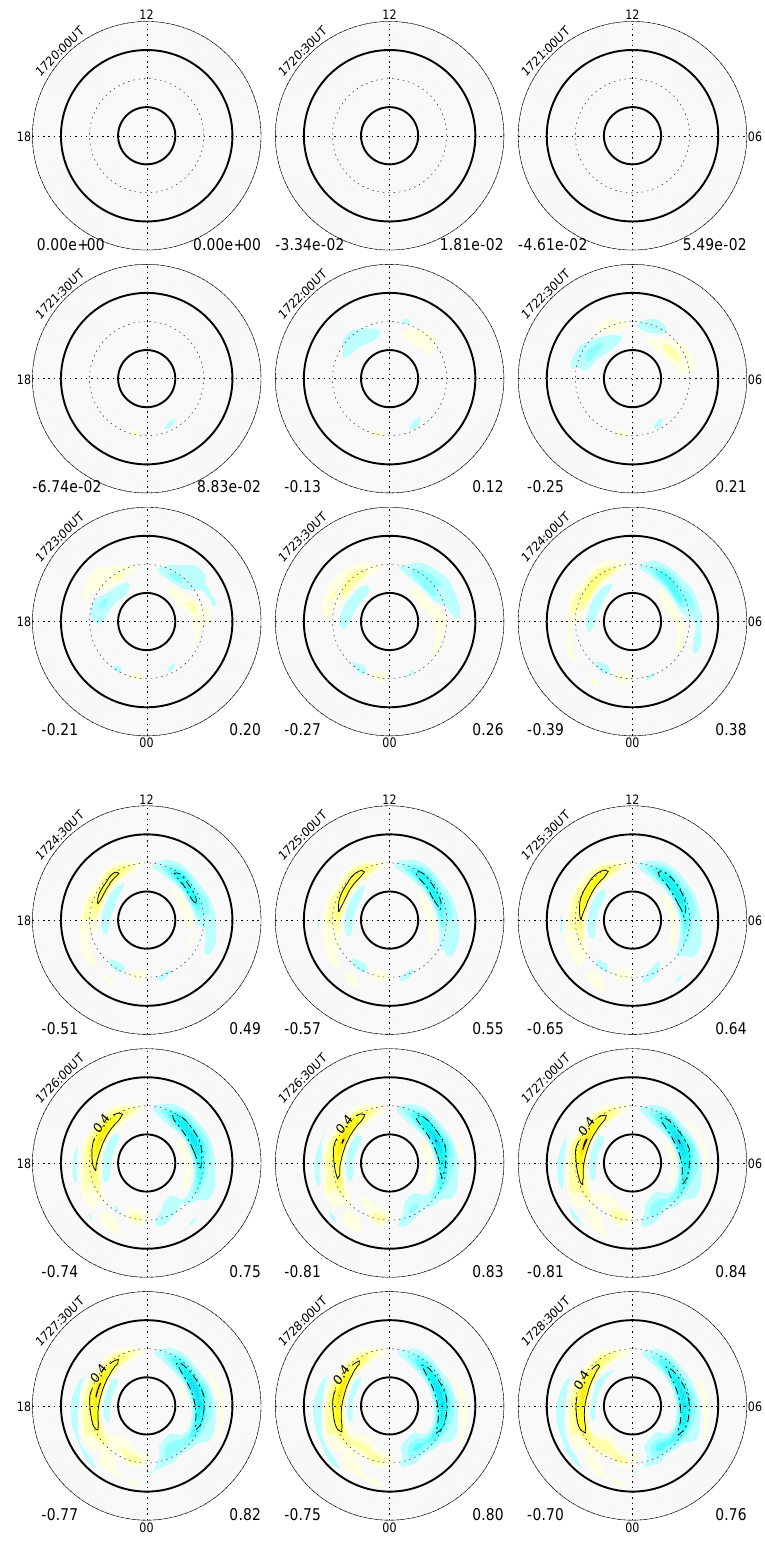
Fig. 3. Residual field-aligned current patterns in the Northern Hemisphere after the pressure enhancement hits the magnetosphere with southward IMF conditions. They are obtained in the same way as that of residual potential patterns. The yellow represents the upward flow of the current, while blue is